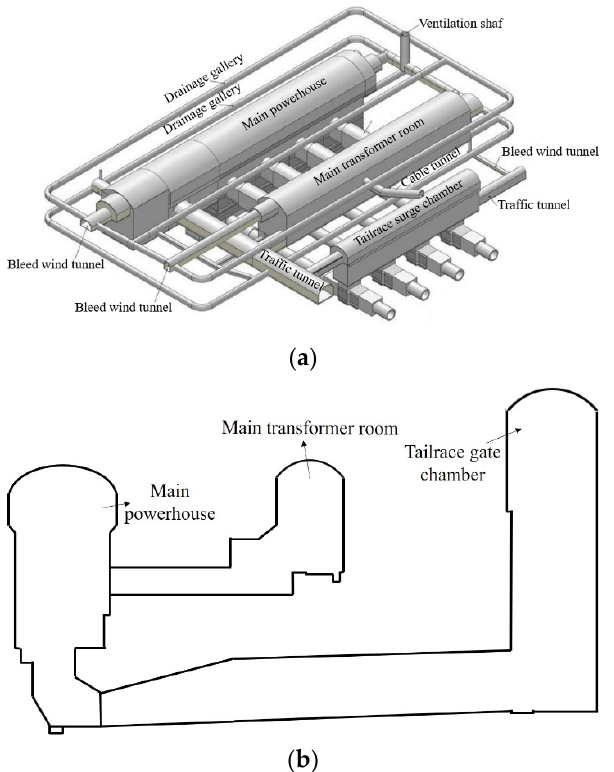
Figure 1. The arrangement and typical excavation section of hydropower caverns. ( a ) The arrange- ment of hydropower caverns [9]. ( b ) The typical excavation section of hydropower caverns.